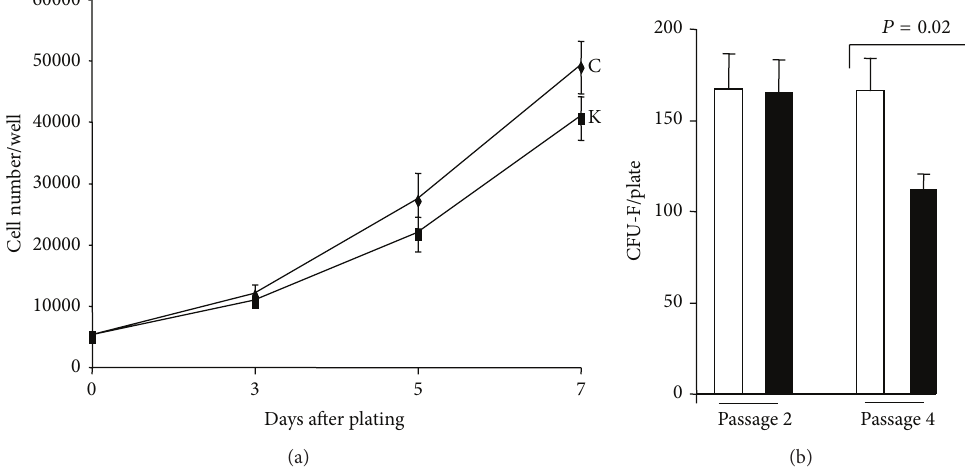
Figure 3: Proliferation and clonogenic potentials of chin and knee ASCs. (a) ASCs isolated from chin (C) and knee (K) were plated at 5000 cells/well in 24-well plates and cell number was quantified at the indicated times. Values are means ± SEM. ( 𝑛 = 8 paired depots). (b) Chin- ASCs (open bars) and knee-ASCs (black bars) were plated at a clonal cell density and maintained in proliferative medium. The numbers of colonies were assessed after 10 days of culture. Values are means ± SEM. 𝑃 is indicated. Experiments were performed at cell passage 2 ( 𝑛 = 7 paired depots) and at passage 4 ( 𝑛 = 6 paired depots).